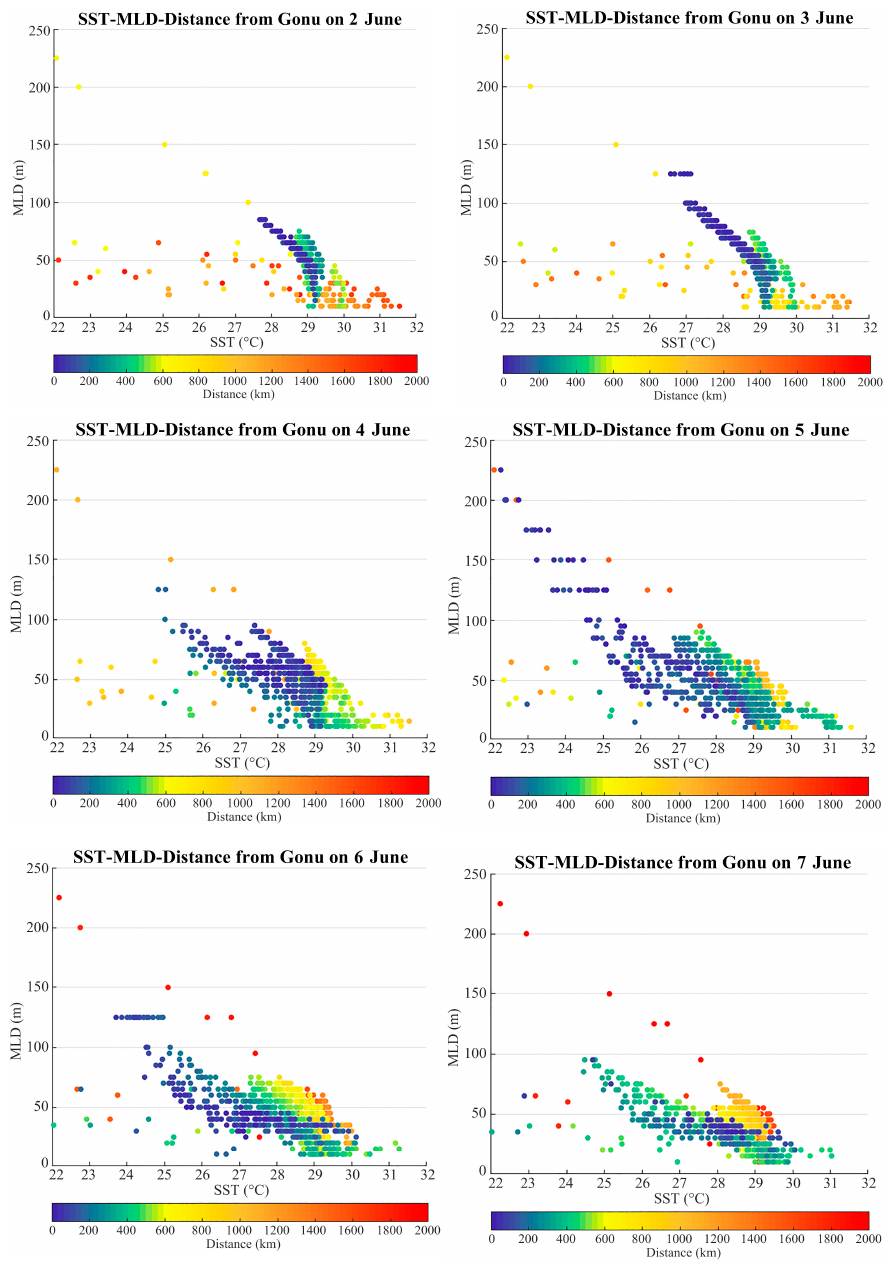
Figure 6. Scatter plots of MLD vs satellite SST values on dates when Gonu passed over the study area. Point colors show distance from the cyclone’s center (km).